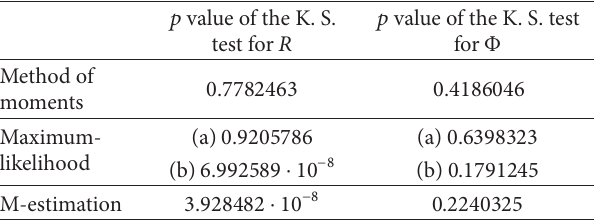
Table 3: Kolmogorov-Smirnov tests of the data against the esti- mated distribution